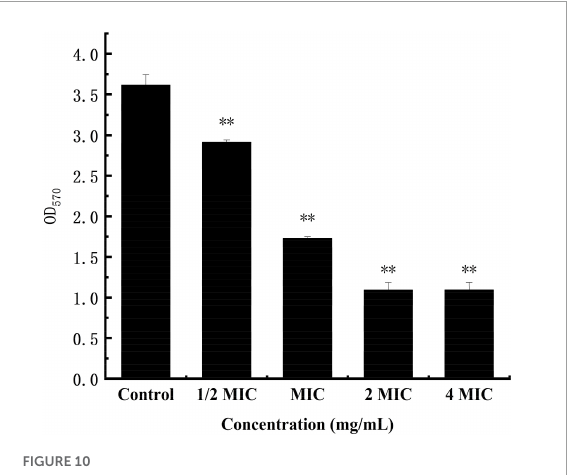
FIGURE10 Effect of anthocyanin on the biofilm metabolism of Staphylococcus aureus by MTT staining method. ∗∗ P <